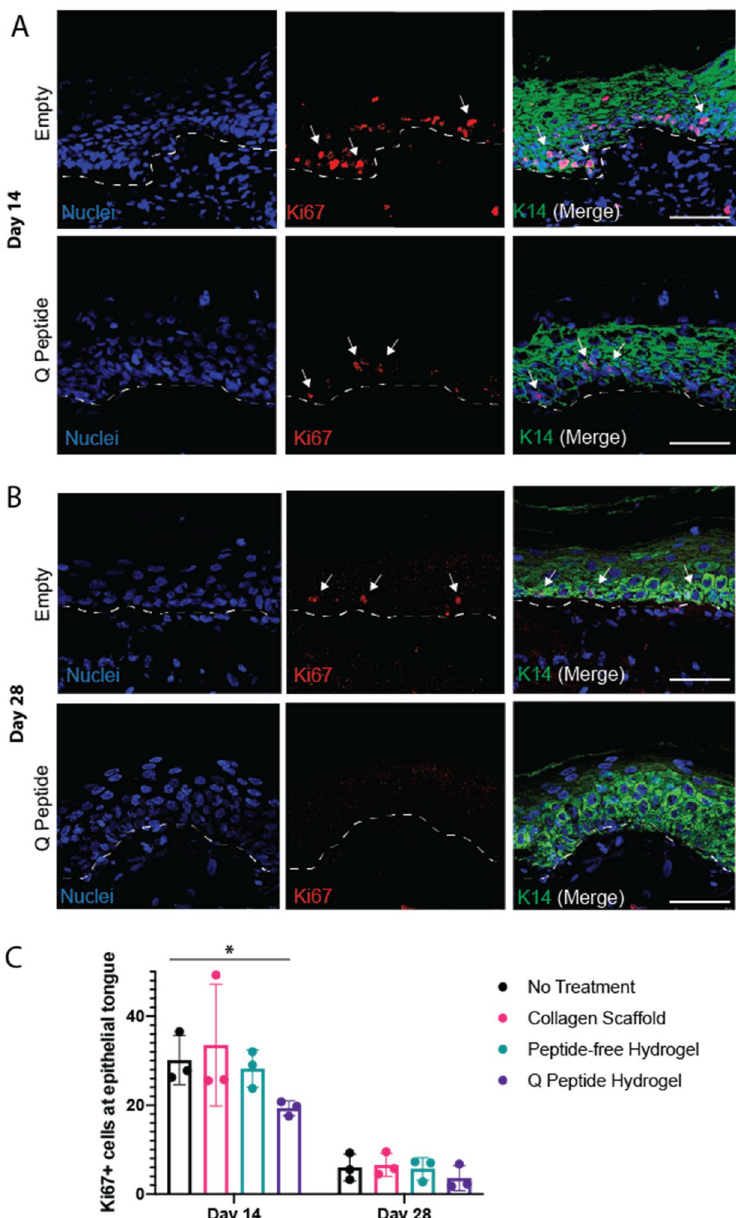
Figure 5. Treatment with Q-Peptide Hydrogel leads to faster resolution of proliferating keratinocytes at the margin of the wound. Representative sections of immunohistochemical analysis for Ki67 at ( A ) d14 and ( B ) d28. Dashed line indicates basal epithelial layer. Arrows show Ki67 positive nuclei. (scale bar = 100 µm). ( C ) Quantification of total number of Ki67+ cells in one high powered field of view at the epithelial edge (averaged from 4 separate tissue sections spanning the center of the wound) revealed significantly fewer proliferating basal epithelial cells on Day 14 following treatment with Q-Peptide Hydrogel compared with no treatment control. Data are presented as mean ± SD. * p < 0.05, N =